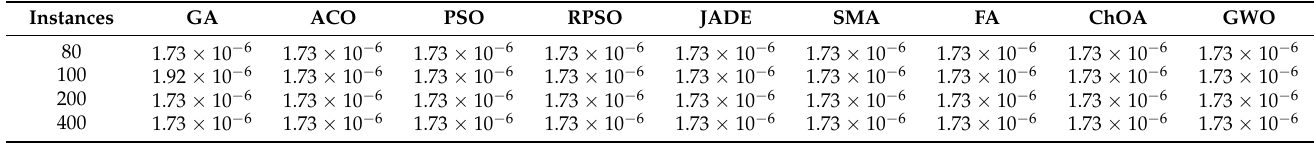
Figure 13. Optimal paths found by the proposed algorithm. Table 5. The results of Wilcoxon rank-sum test results for low-dimensional